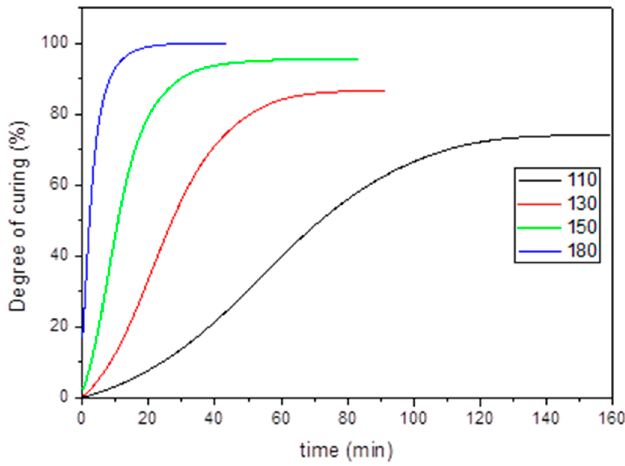
Figure 3 . Curing degree of aero grade epoxy vitrimer at different temperatures. Figure 3. Curing degree of aero grade epoxy vitrimer at different temperatures.